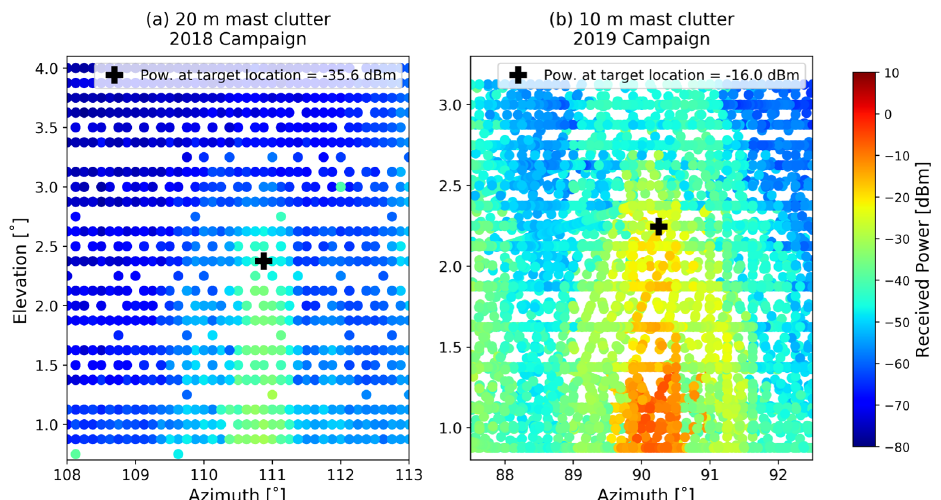
Figure 5. Clutter retrieval from the 10m (a) and 20m masts (b) , respectively. Masts are scanned without the reflectors to measure the clutter signal. The nominal target position is marked with a black